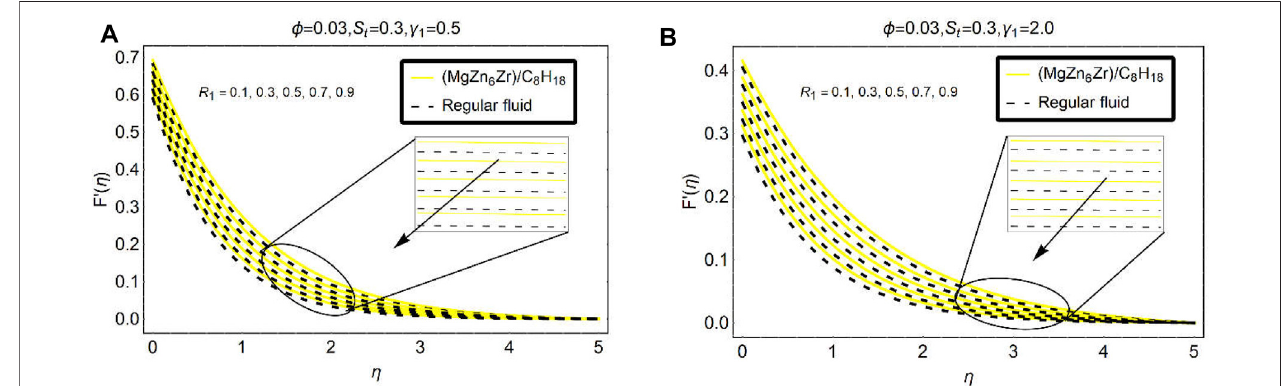
FIGURE 3 | Velocity via R 1 for (A) γ 1 (cid:2) 0 . 5 and (B) γ 1 (cid:2) 2 . 0.